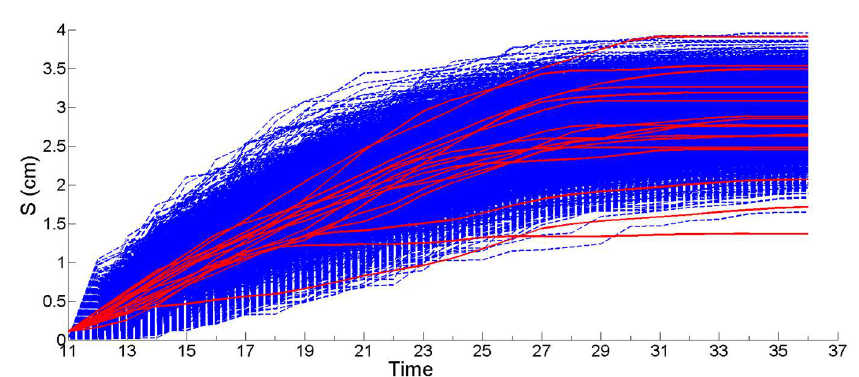
Figure 7. Individual growth trajectories obtained with the DEB model for each year of the 17 year time series (solid red lines) compared with simulated individual growth obtained with the Gamma process approach (dotted blue lines). The time unit represents 10 day periods.